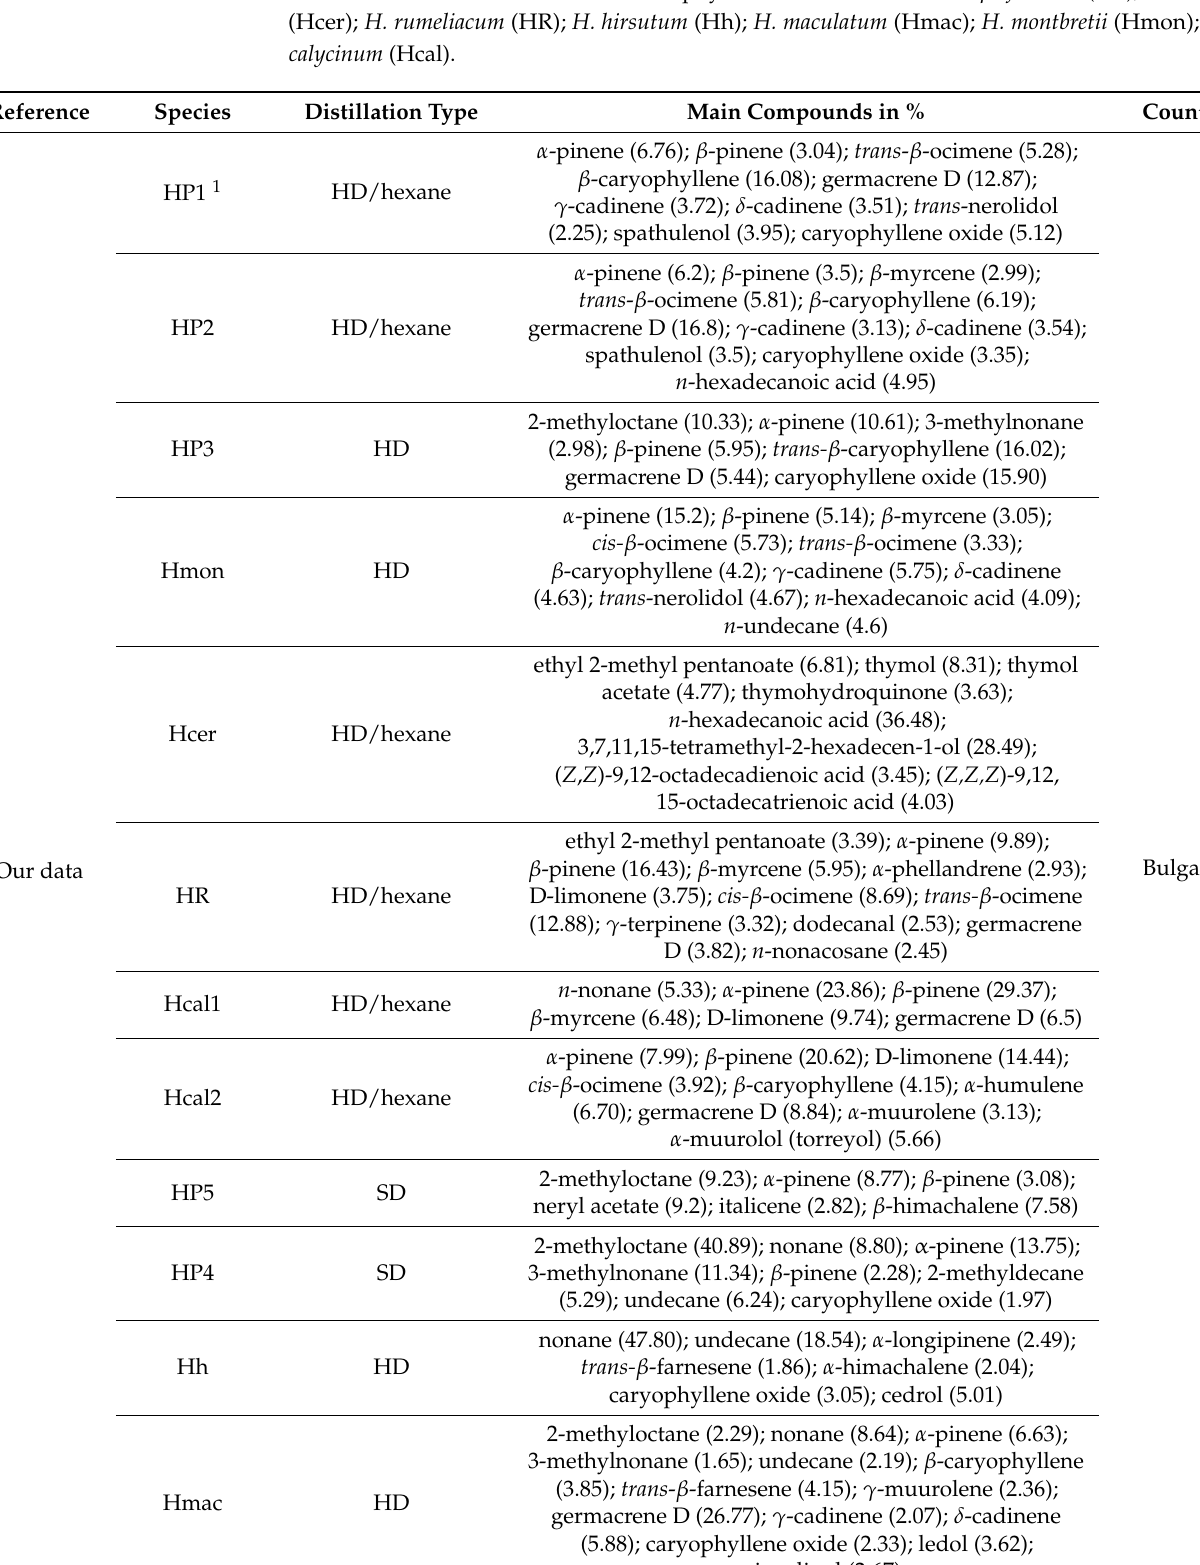
Table 1. Our data and literature data of phytochemical research on H. perforatum (HP); H. cerastoides (Hcer); H. rumeliacum (HR); H. hirsutum (Hh); H. maculatum (Hmac); H. montbretii (Hmon); and H. calycinum